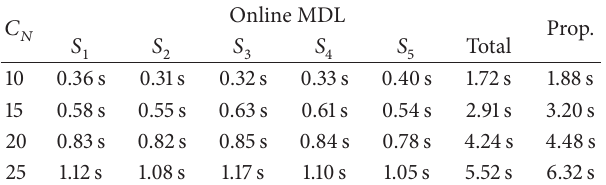
Table 4: Time cost of 5